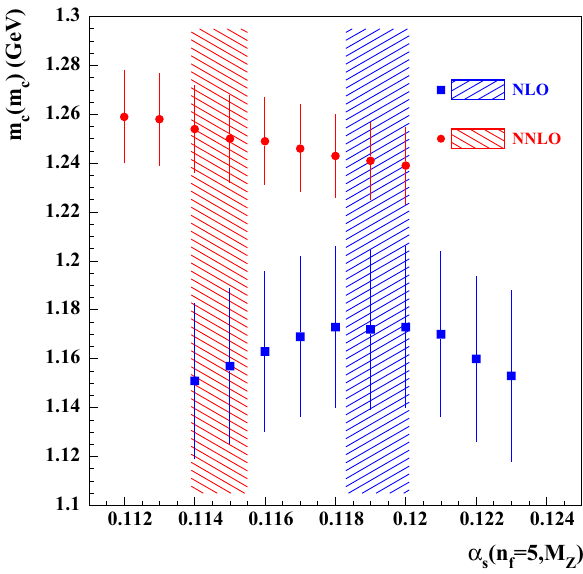
Fig. 4 The same as in Fig. 3 for the MS value of the c -quark mass ( n f = 5 ) ( M ) fixed (squares) in m c ( m c Z s ( n f = 5 ) ( M ) obtainedintheABMP16 Z s